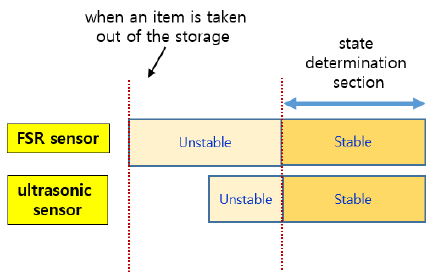
Figure 9. Changes in the measured values of the ultrasonic sensor and the FSR sensor when an item was taken out of the smart storage.